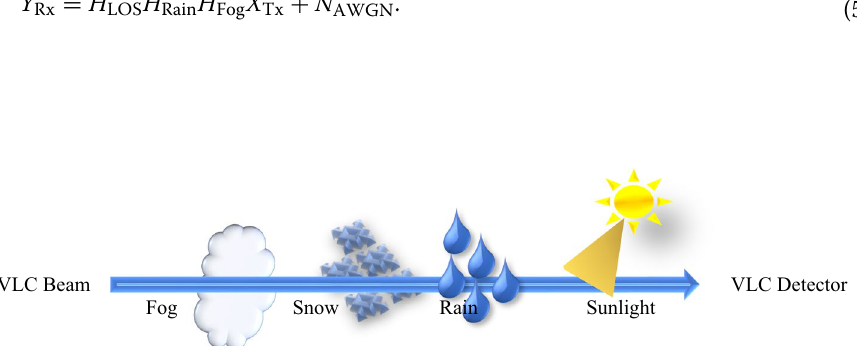
Fig. 2 The VLC channel characteristics at different weather conditions. The received signal is affected by the channel attenuation coefficients such as fog, rain, dust, and snow. Moreover, the additive white